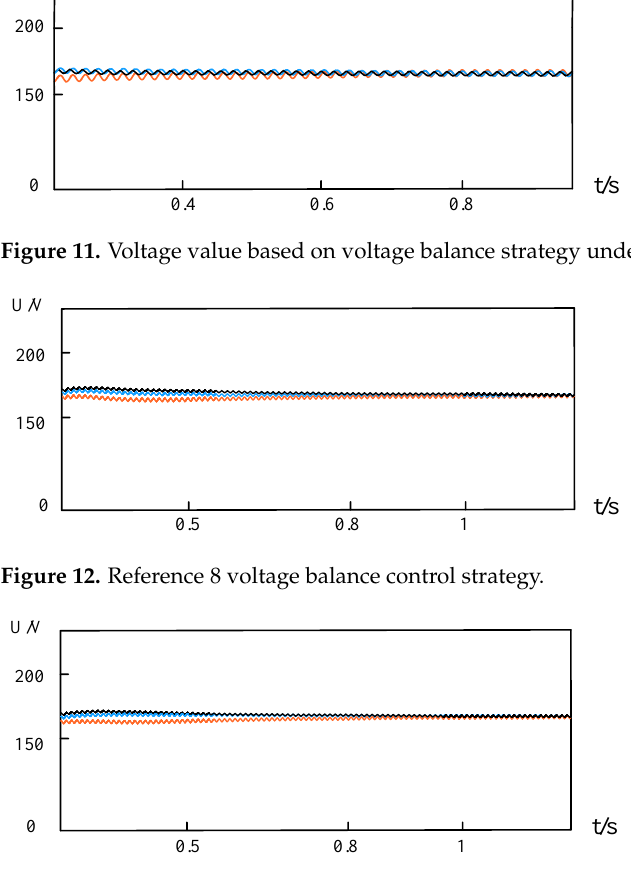
Figure 13. Reference 9 voltage balance control strategy.